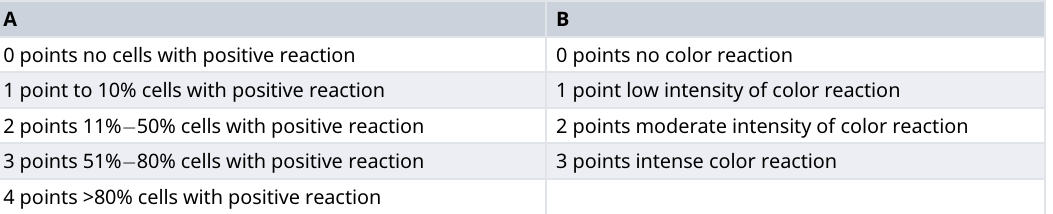
Table 1. Semiquantitative IHC scale taking into account both percentage of positive cells (A) and intensity of reaction color (B) with the final score representing the product of the two variables (A (cid:3) B). 36 A B 0 points no cells with positive reaction